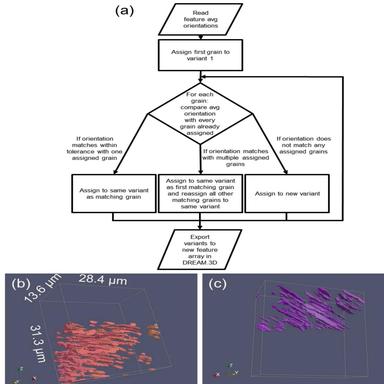
(a) A flowchart representation of the algorithm for grouping grains of similar orientations into variants. The input is the average orientation of each grain, and after the first grain is assigned to variant 1, the orientation of each subsequent grain is checked against each previously assigned grain and added to the variant of any grain that it matches or assigned a new variant if it matches none. (b and c) Two examples showing all the grains of two different variants from the Linear sample.